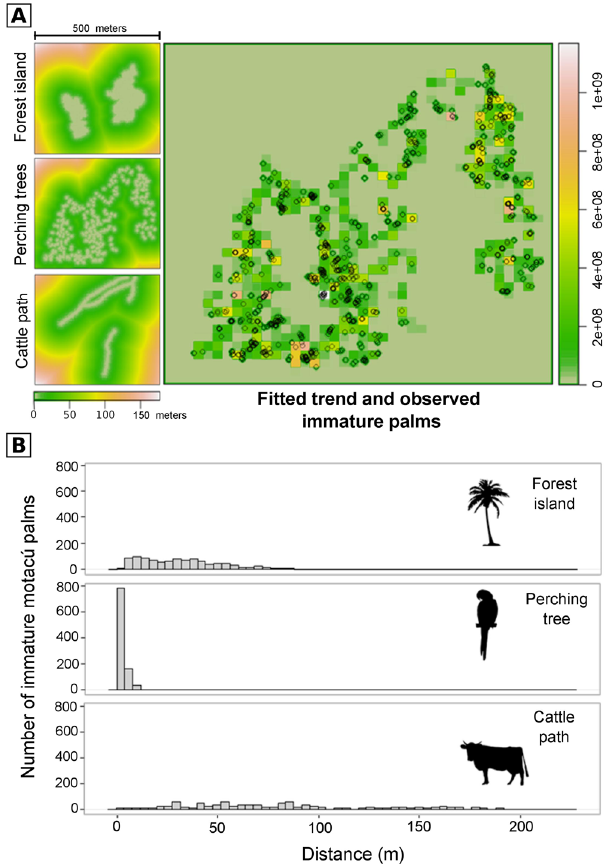
Figure 5. Spatially explicit analysis of motacú palm recruitment. ( A ) On left, spatial covariates (distances to forest islands, perching trees and cattle paths) used to model the spatial distribution of immature motacú palms. The main square is the spatial fitted trend of the best model (including all of the previous covariates), and the observed distribution of immature palms represented with circles. ( B ) Distribution of distances (m) of immature motacú palms to the nearest forest island, perching tree and cattle